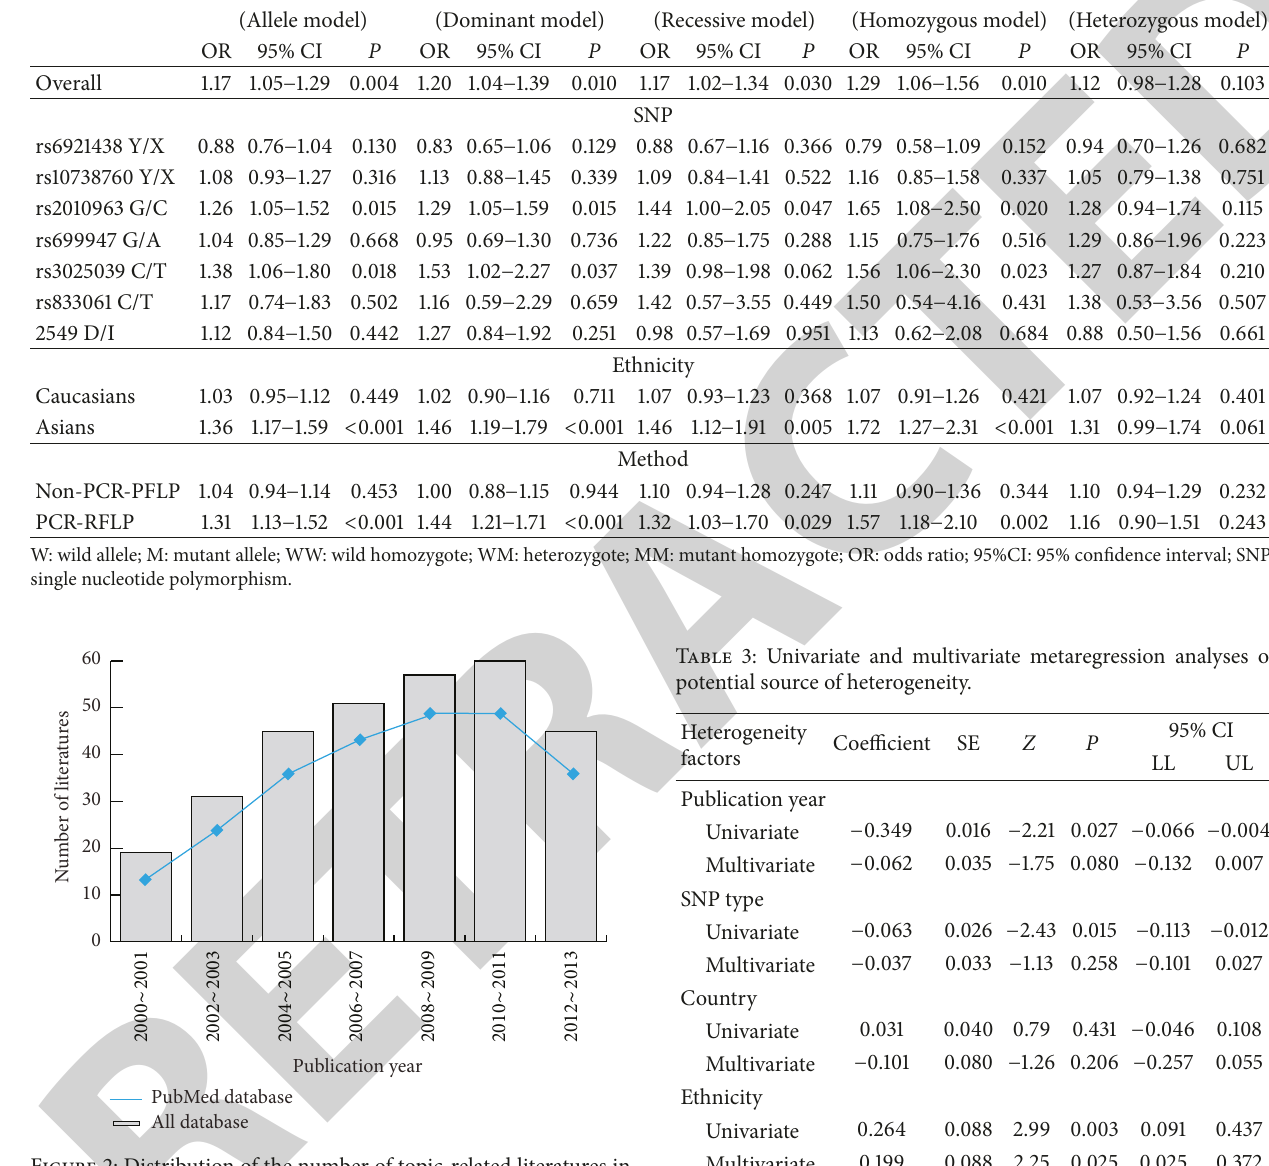
Table 2: Meta-analysis of the relationships of VEGF genetic polymorphisms with the risk of diabetic nephropathy in patients with diabetes mellitus. M allele vs. W allele WM + MM vs. WW